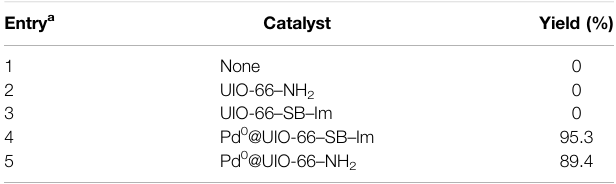
TABLE 2 | Catalytic performances of different catalysts for the Suzuki coupling reaction.